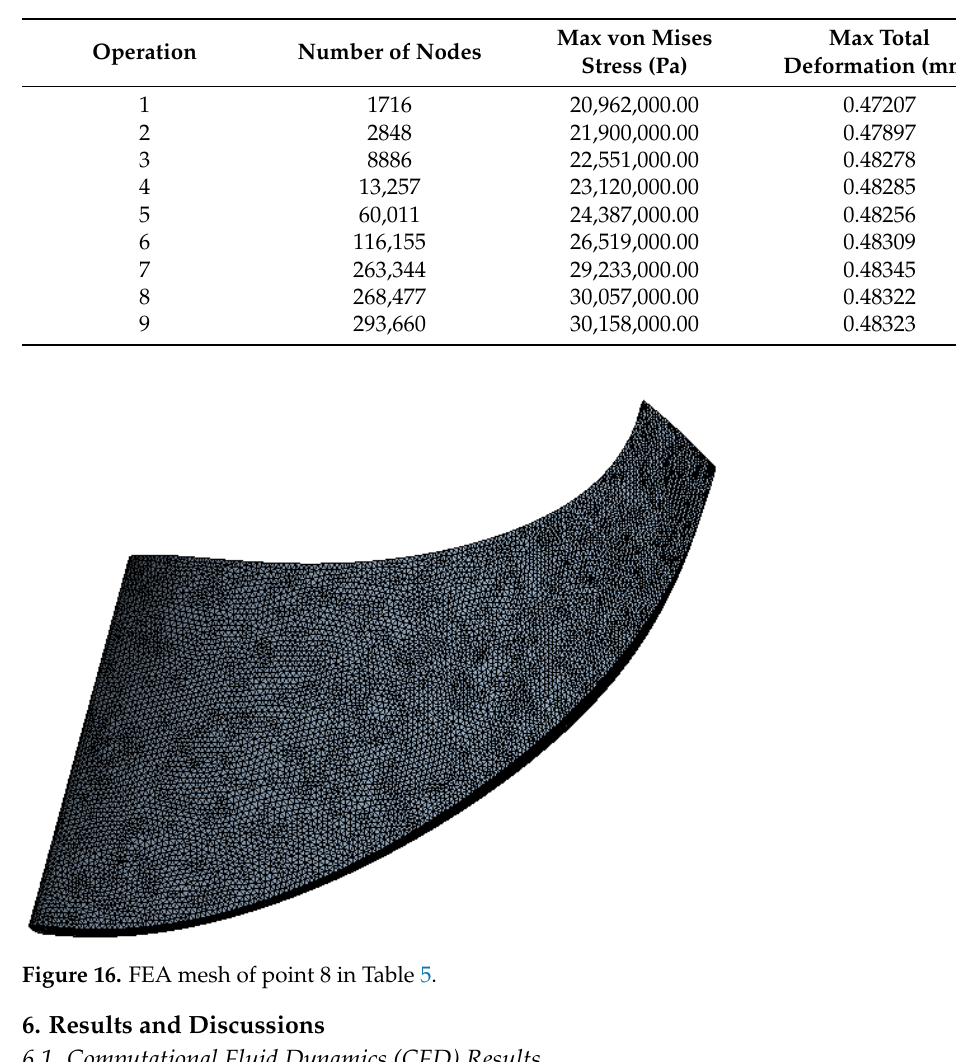
Table 5. Results of FEA mesh independence study.